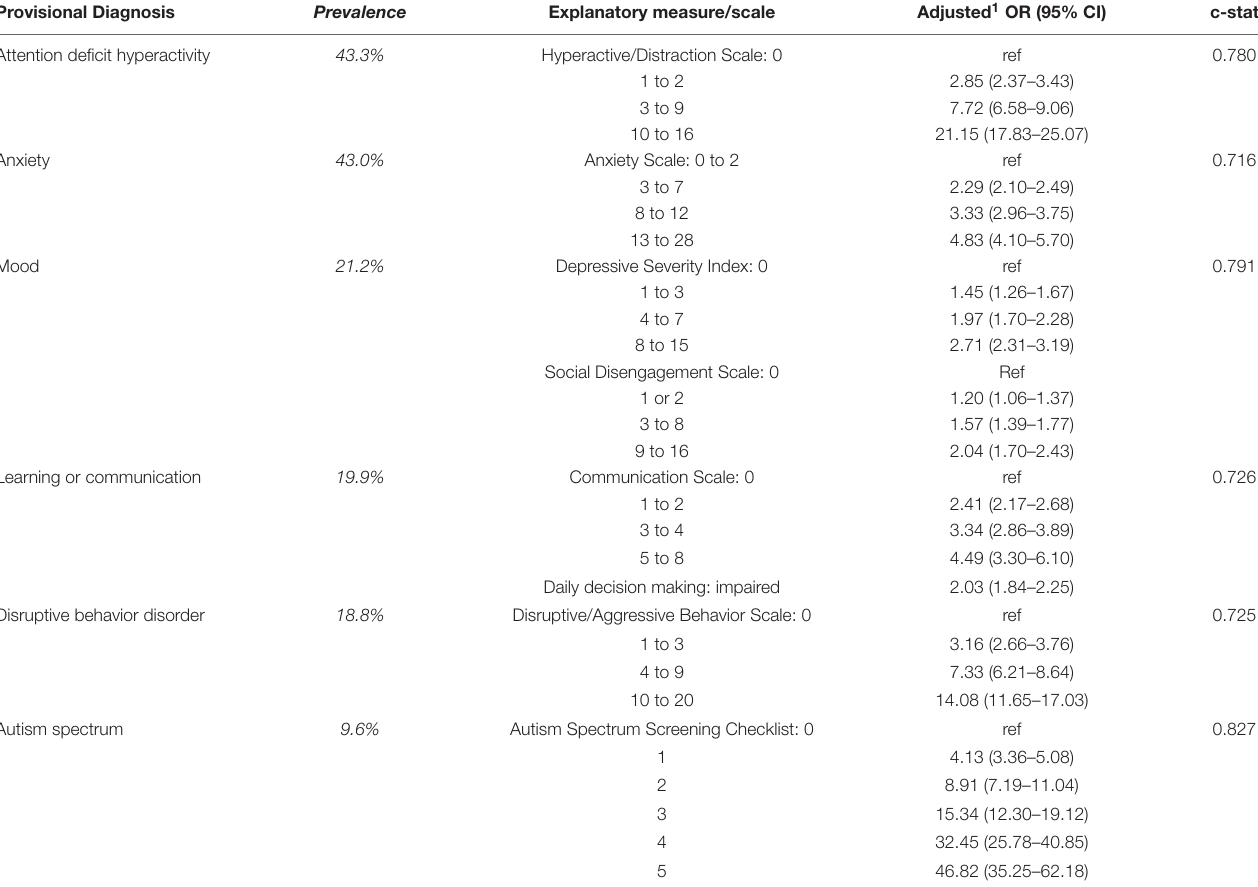
TABLE 4 | Odds ratios (95% CL) for provisional psychiatric diagnoses by associated symptoms. Provisional